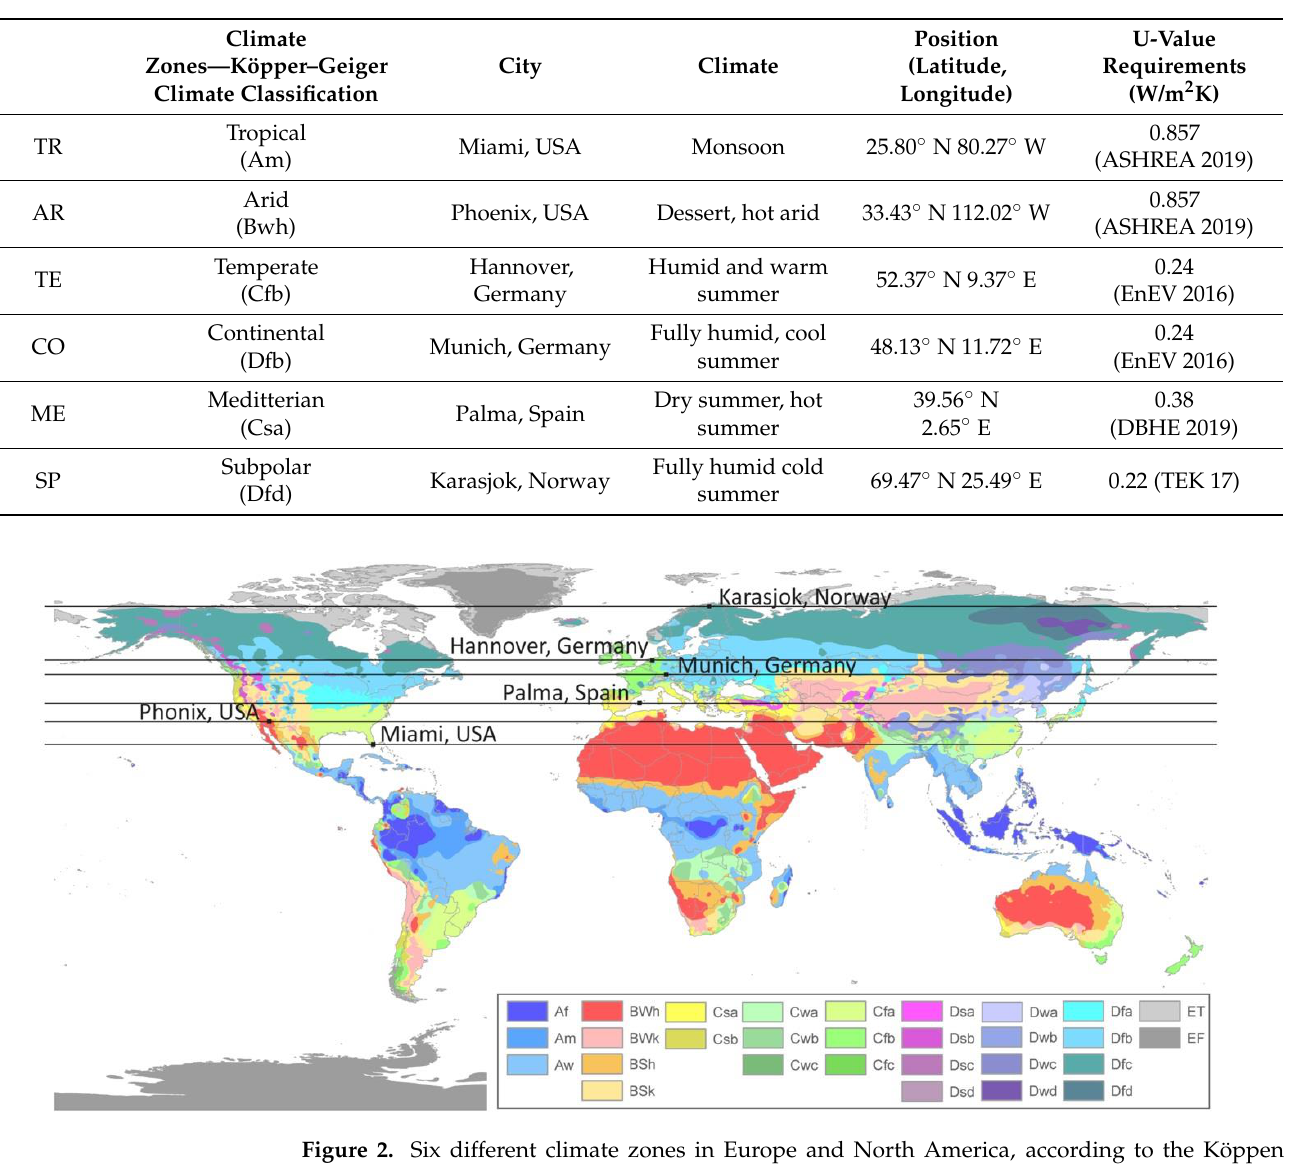
Table 1. Exterior weather conditions.